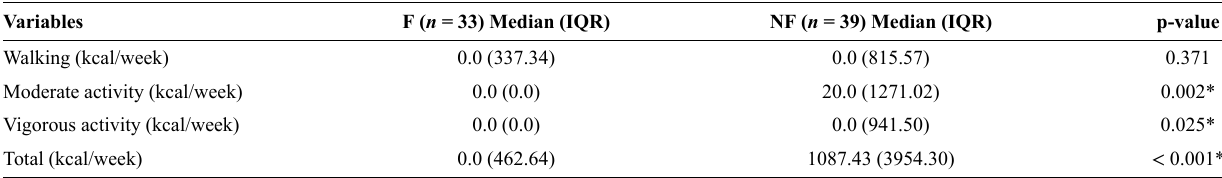
Table 3 - Total calorie expenditure and calories expended during walking, moderate, and vigorous activities in frail and non-frail older adults. Variables F ( n = 33) Median (IQR) p-value Walking (kcal/week) Moderate activity (kcal/week)